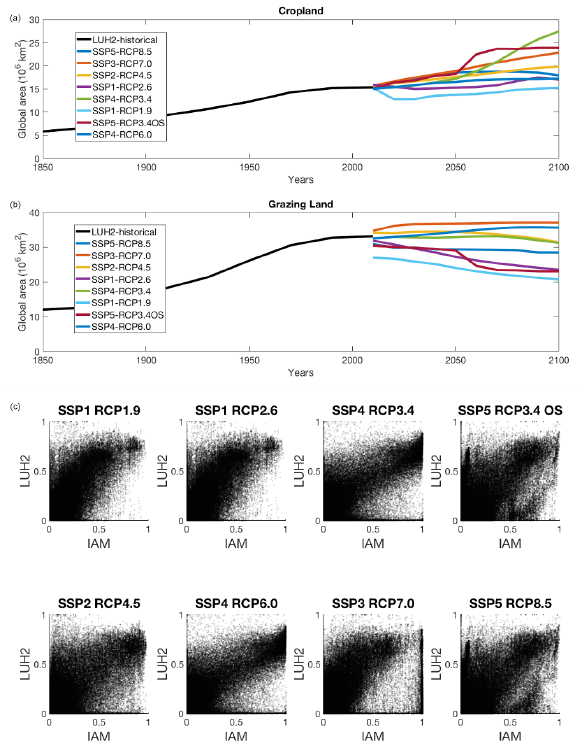
Figure 4. Pre-harmonization (a) global cropland, (b) global graz- ing land, and (c) 0.25 ◦ grid cell comparison of 2015 crop fraction of grid cell areas (excluding water and ice): IAM ( x axis), LUH2 ( y